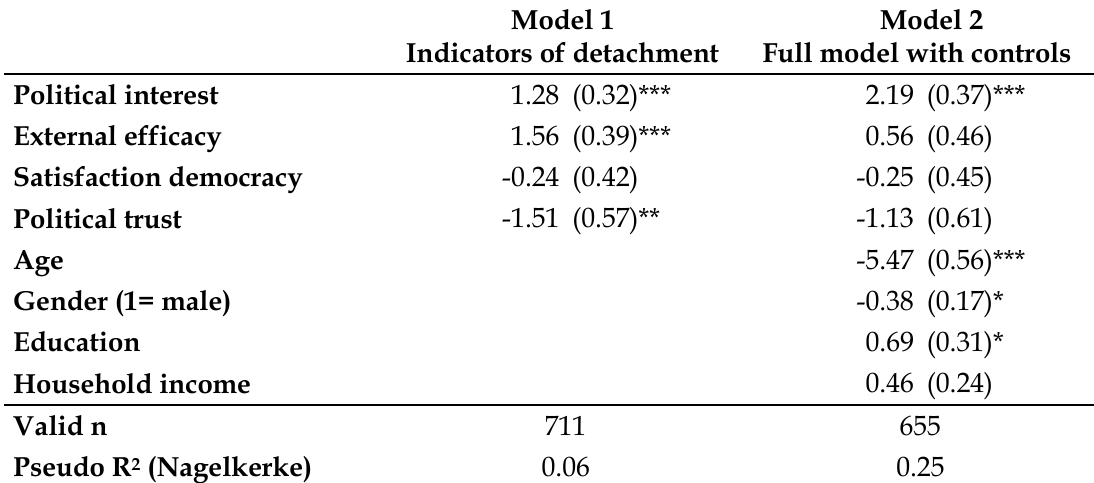
Table 3: Internet activism and digital